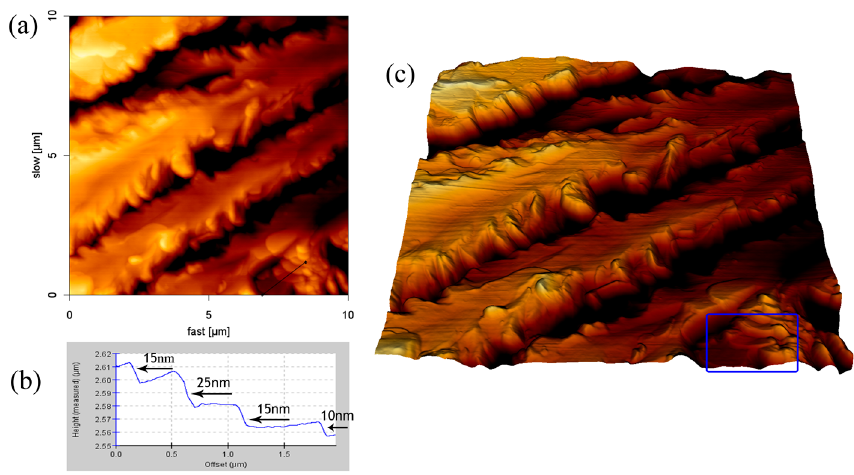
Figure 6. AFM result of SDS-NaCl aggregates of the surface of the glass: ( a ) height image; ( b ) cross-section height profiles along the line in (a); and ( c ) 3D reconstruction image.